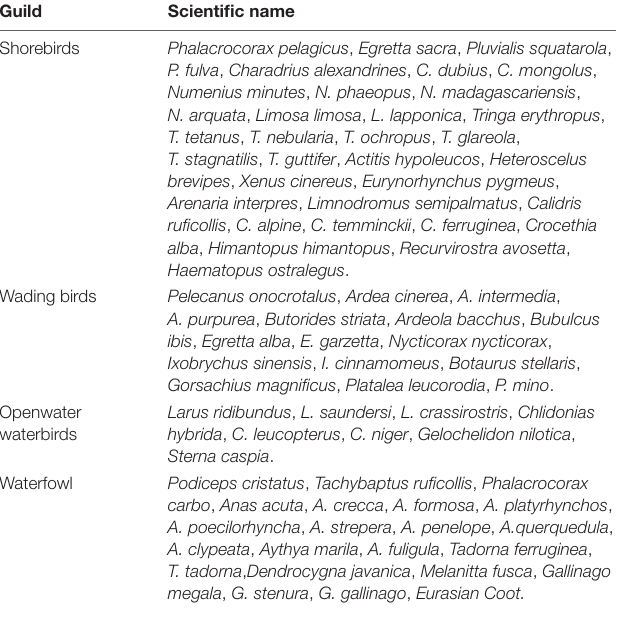
TABLE 1 | List of waterbird species recorded during a field survey of coastal sites in Guangdong Province, China classified by foraging